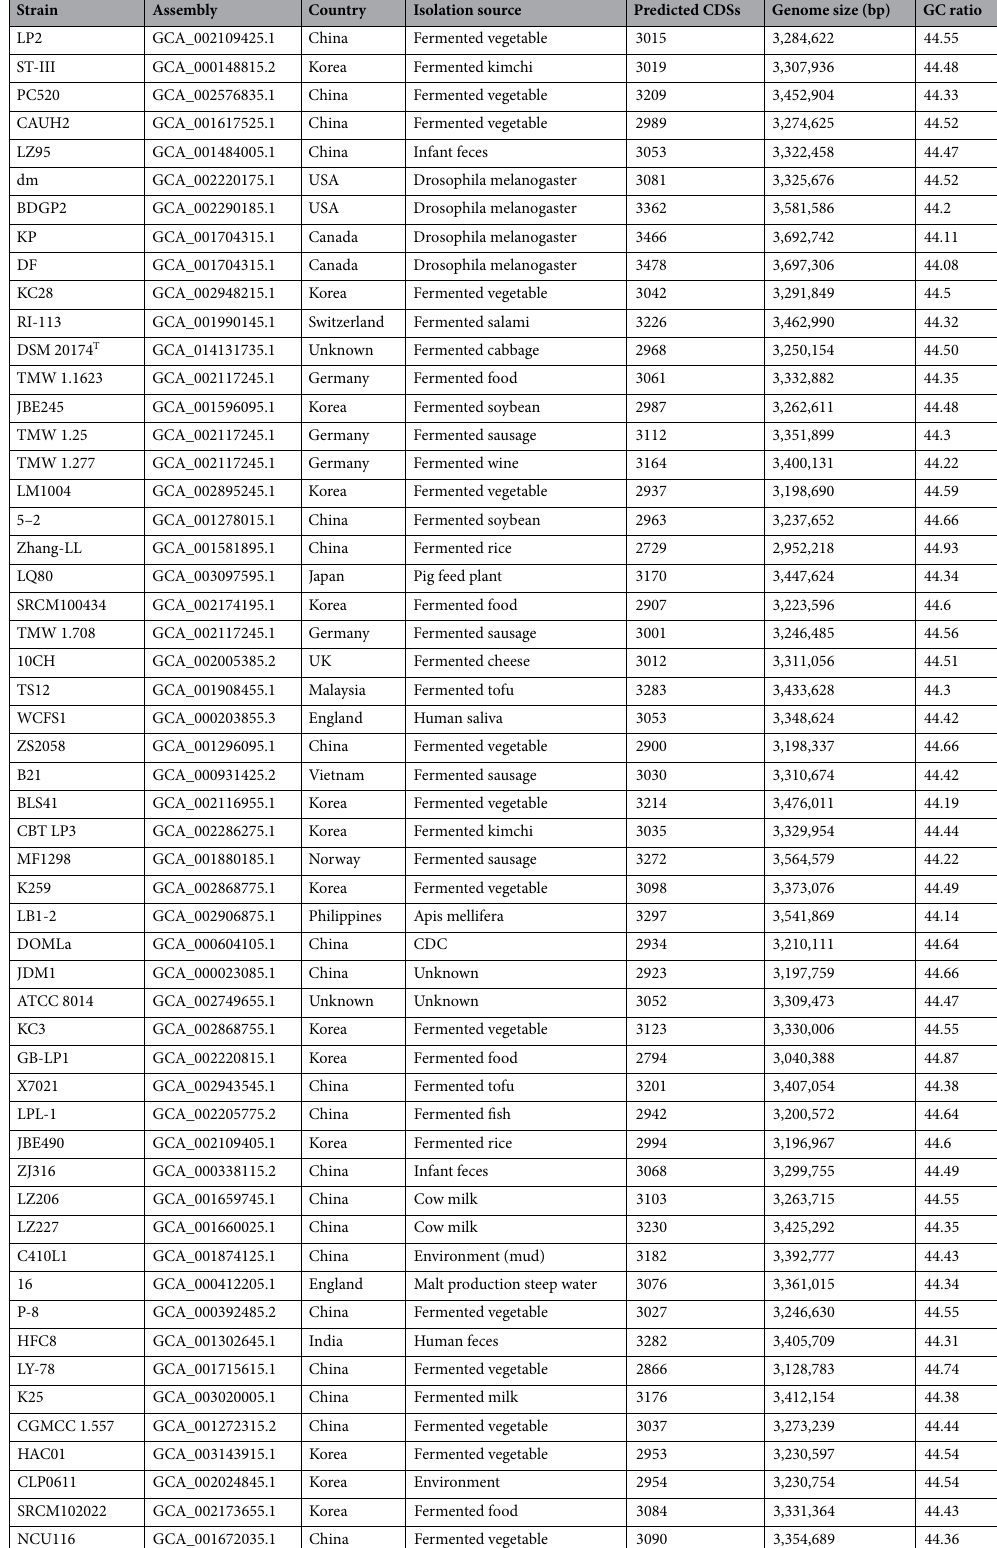
Table 1. List of the complete genome sequences analyzed in this study. The 54 genome sequences of Lactiplantibacillus plantarum subsp. plantarum available in the public database were included in this study. The type strain genomes of L. plantarum subsp. argentoratensis DSM 16365 T (GCA_003641165.1) and L. paraplantarum L-ZS9 T (GCA_001443645.1) were used as outgroups but are not presented in this table. The strain information was obtained from the biological descriptions provided in the NCBI